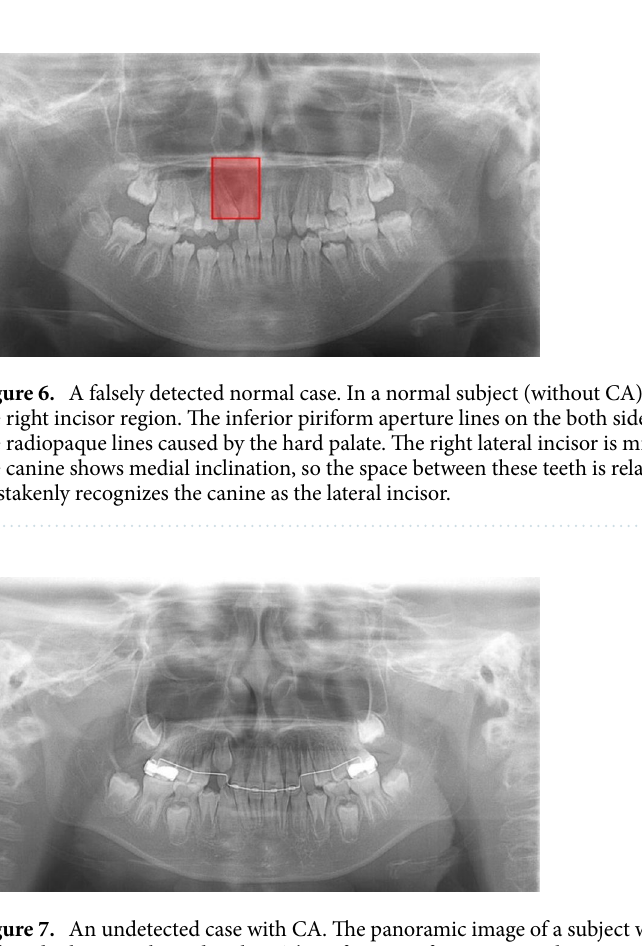
Figure 7. An undetected case with CA. The panoramic image of a subject with CA (CA only group) on the right side shows no bounding box. The inferior piriform aperture lines are observed at almost equal levels, and the right lateral incisor shows no characteristic